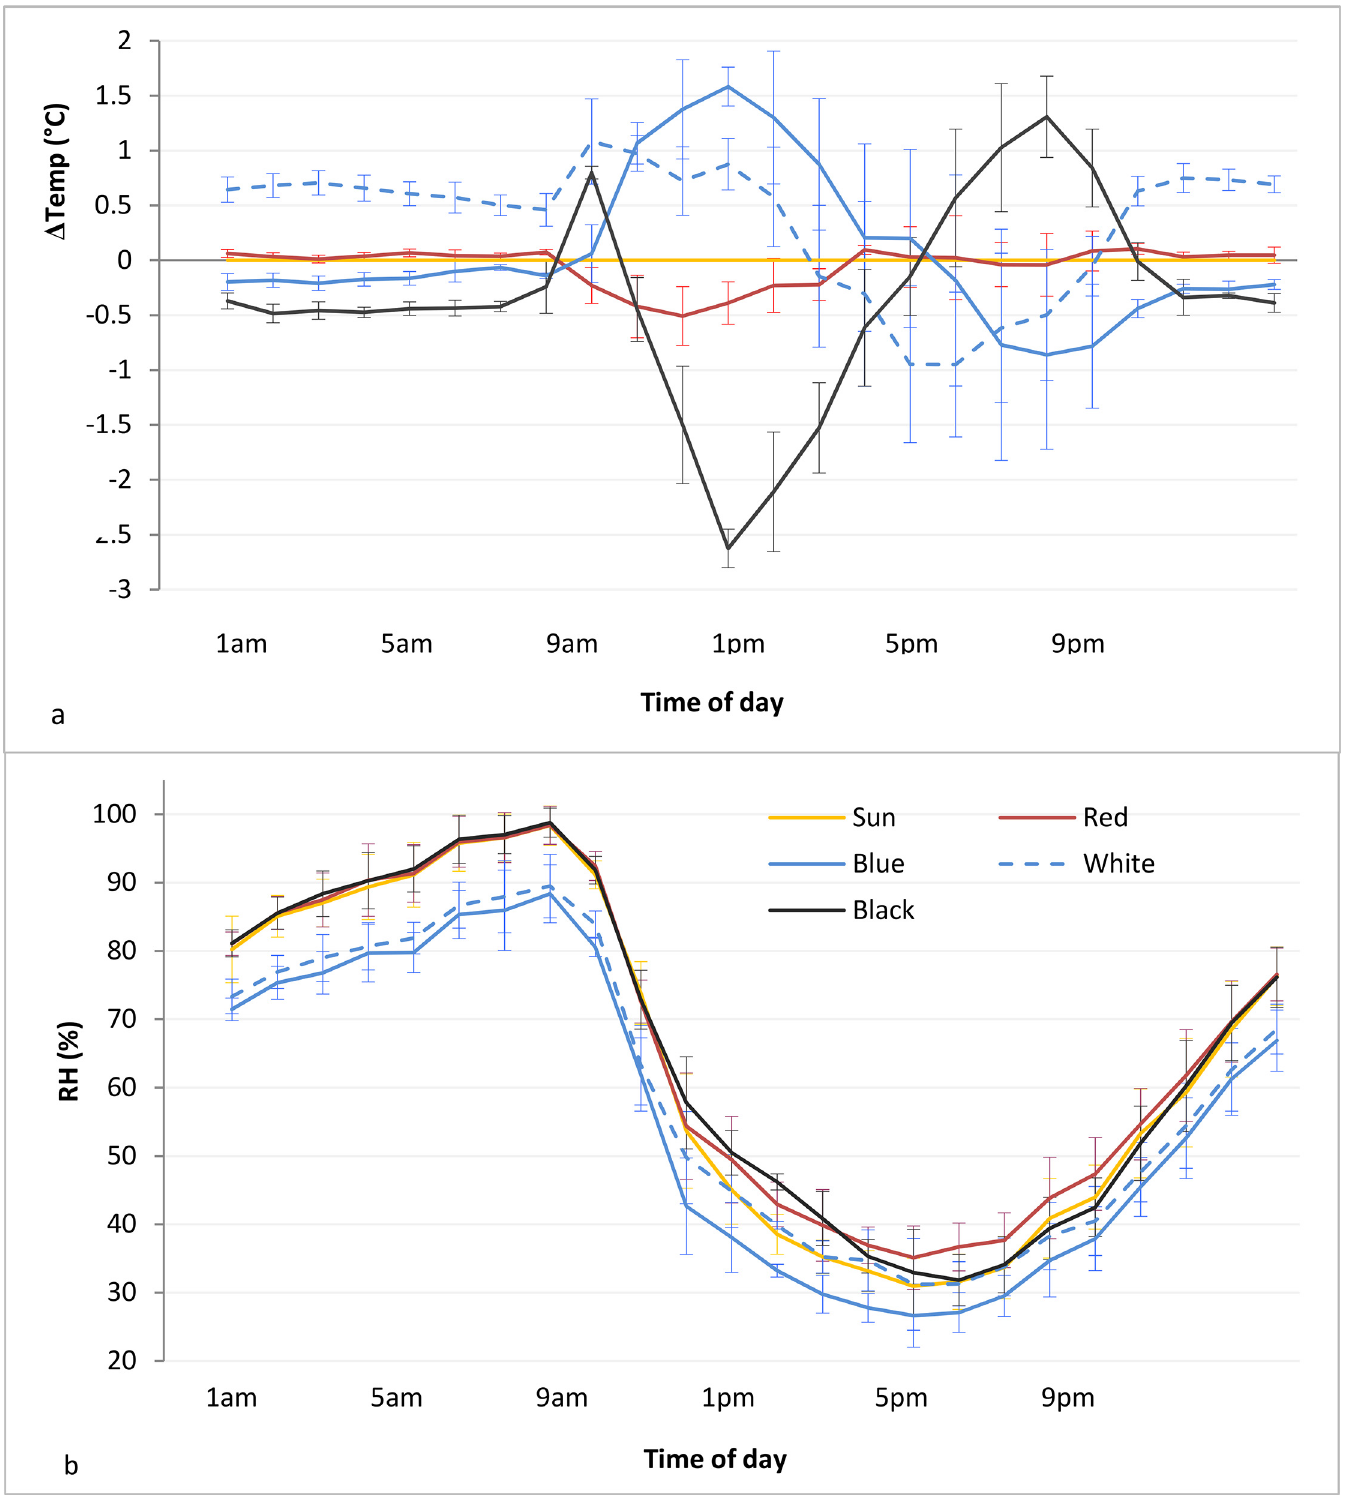
Fig 2. Temperature (a) and relative humidity (RH; b) measured under colored photo-selective nets. Data were recorded every hour continuously for one week during the fruit ripening. Temperature is expressed as difference between temperatures measured under net and under direct sunlight in open-